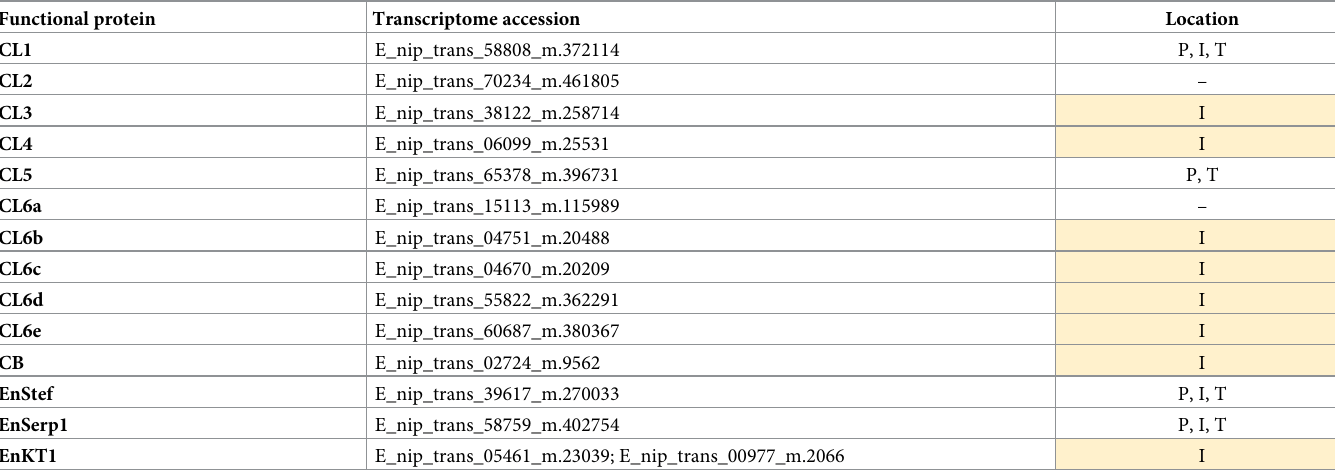
P, parenchyma; I, intestine; T, tegument;–, not identified. Only identification by � 2 peptides in both replicates was taken into account. Highlighted cells mean consensus of data acquired by LCM + LC-MS/MS with the proposed location in a relevant publication